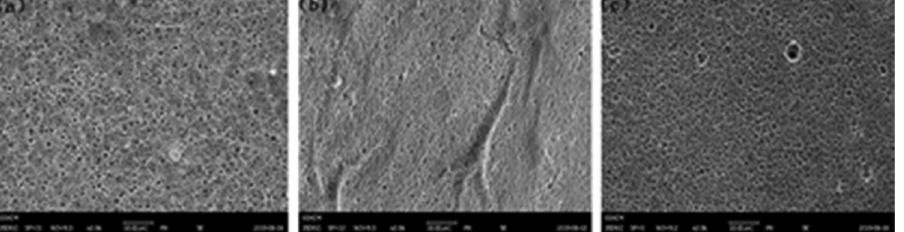
Figure 10: Surface morphology of spanner treated with T liquid for 60 min after anodic oxidation: ( a ) 20 V – 40 min, ( b ) 20 V – 50 min, and ( c ) 20 V – 60 min.